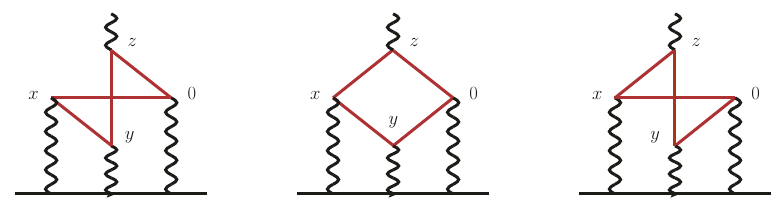
Figure 6 . Wick contractions for the connected contribution in Method